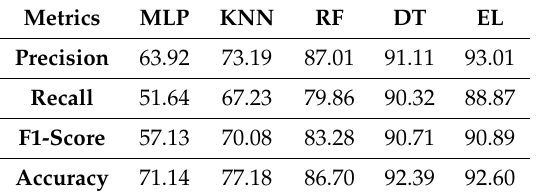
Table 4. Average cross validation score of each model (10-min prediction validity with 80% threshold).